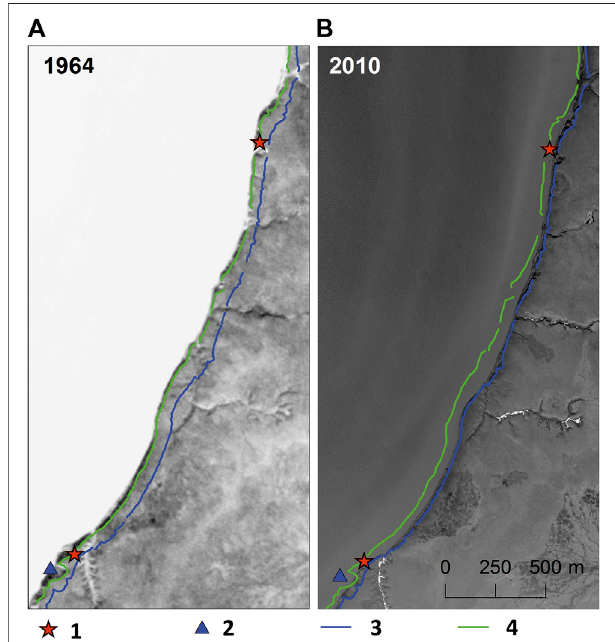
FIGURE 6 | Shorelines of 1964 and 2010 within the area of the fastest erosion and massive ice beds ’ exposure: ( A) Corona image. ( B) WorldView-1 image. 1 — outcrops of massive ice beds in 2016, 2 — outcrops of thermocirques in 2016, 3 — shoreline of 2010. 4 — Shoreline of 1964.